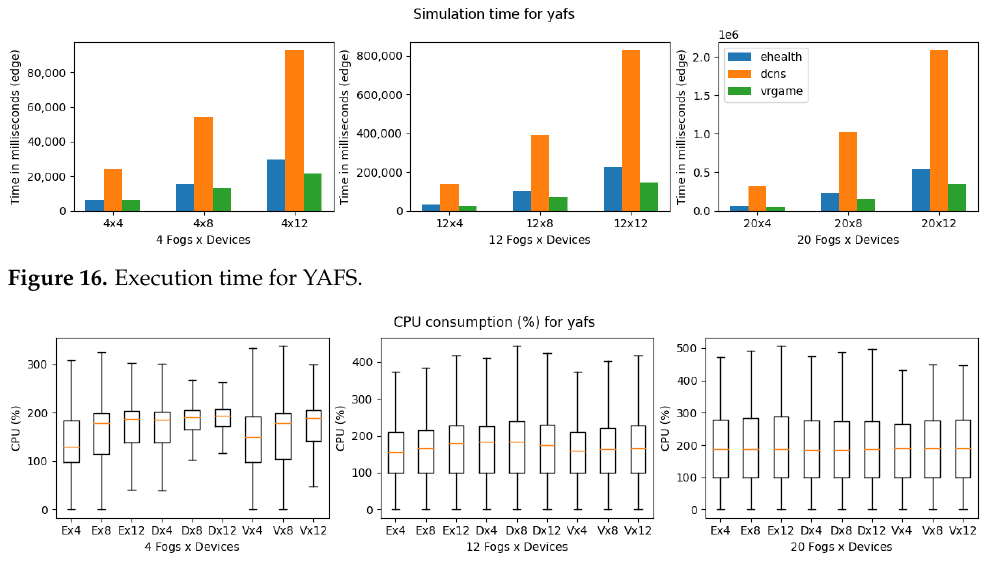
Figure 17. CPU consumption for YAFS during simulation (E: eHealth; D: DCNS; V: